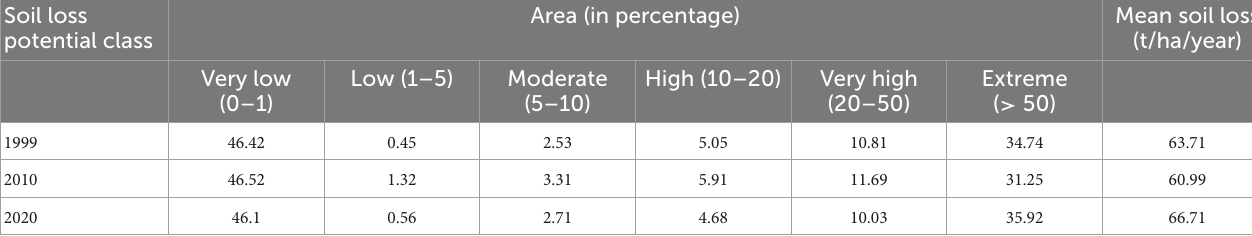
TABLE 6 Area under different soil loss potential classes and mean soil loss for the year 1999, 2010, and